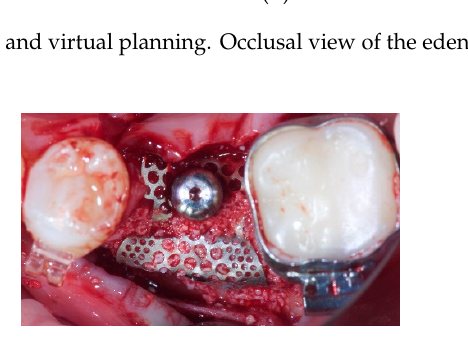
Figure 2. Clinical view at implant placement. The ultra-fine titanium mesh after bone graft. The healing cap was used to anchor the titanium mesh to the height connector.